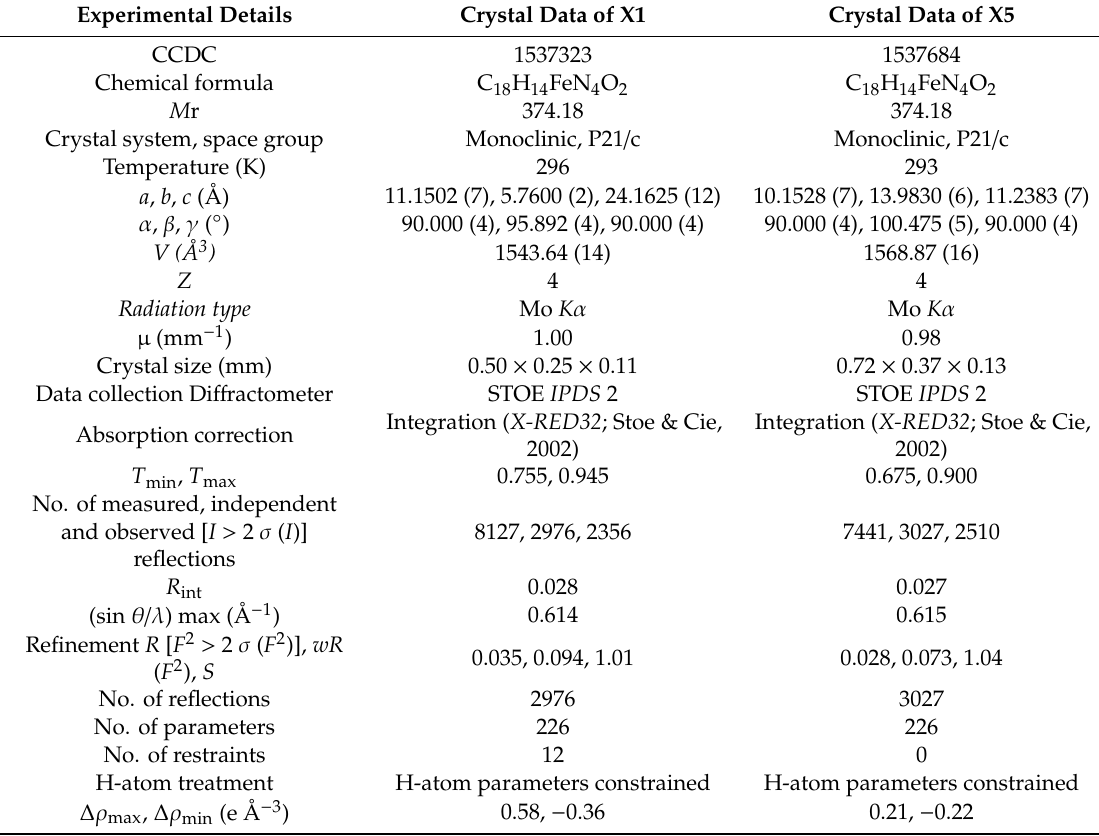
Table 1. Experimental details and crystal structure data for compounds X1 and X5 .